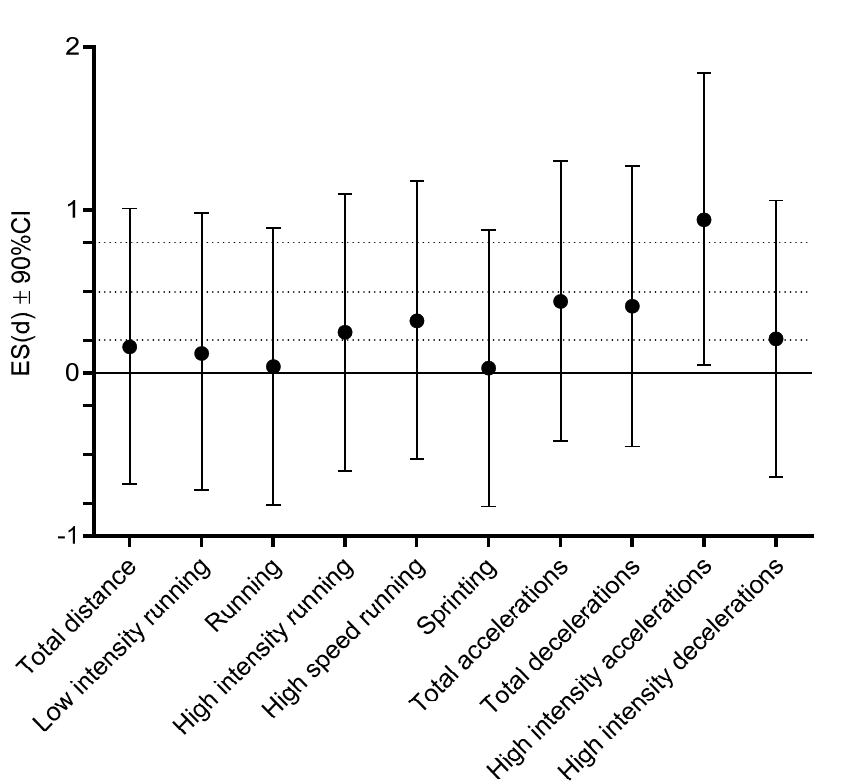
Figure 2. Effect size (ES) differences for match running performances between non-infected players and infected players before being diagnosed with COVID-19 (dashed lines present ES ranges: <0.02 = trivial; 0.2–0.6 = small; >0.6–1.2 = moderate; >1.2–2.0 = large; and >2.0 very large differences). Table 2. Descriptive statistics for match running performances and dependent sample T -test differences within infected players—comparison of the performances before being infected (pre-COVID) and after return to play